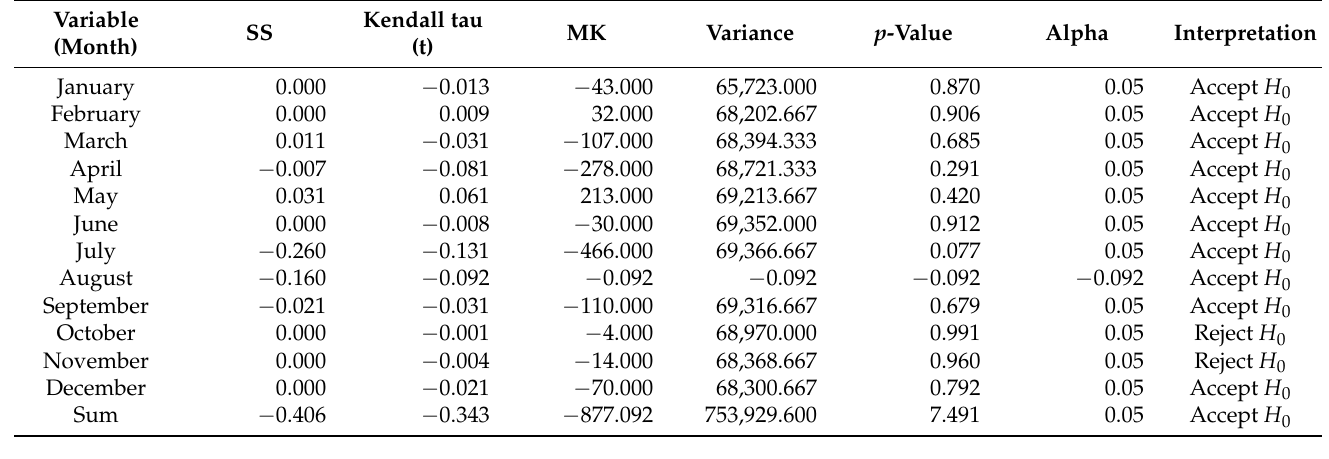
Table 4. SS and MK test results for the Novoselenginsk station.